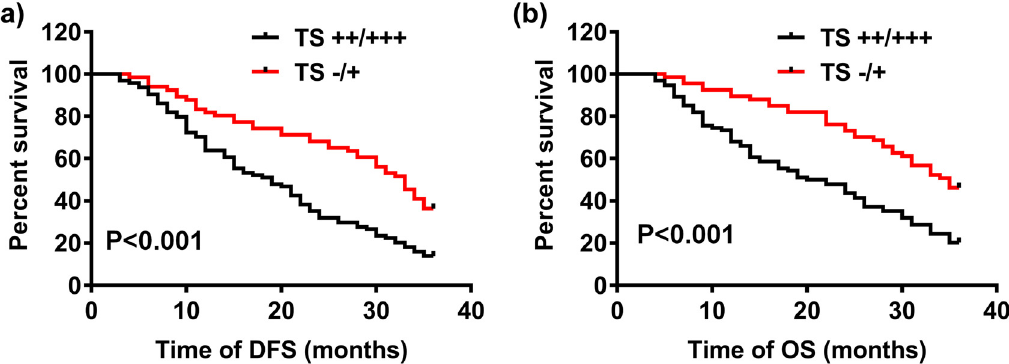
Figure 2: The prognostic value of TS gene in NSCLC. ( a ) Kaplan – Meier curves of disease - free survival ( DFS ) . ( b ) Kaplan – Meier curves of overall survival ( OS )